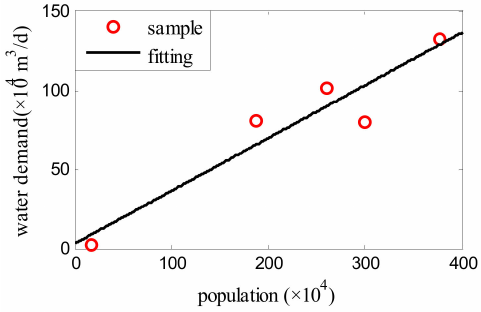
Figure 6. Relationship between the population and water